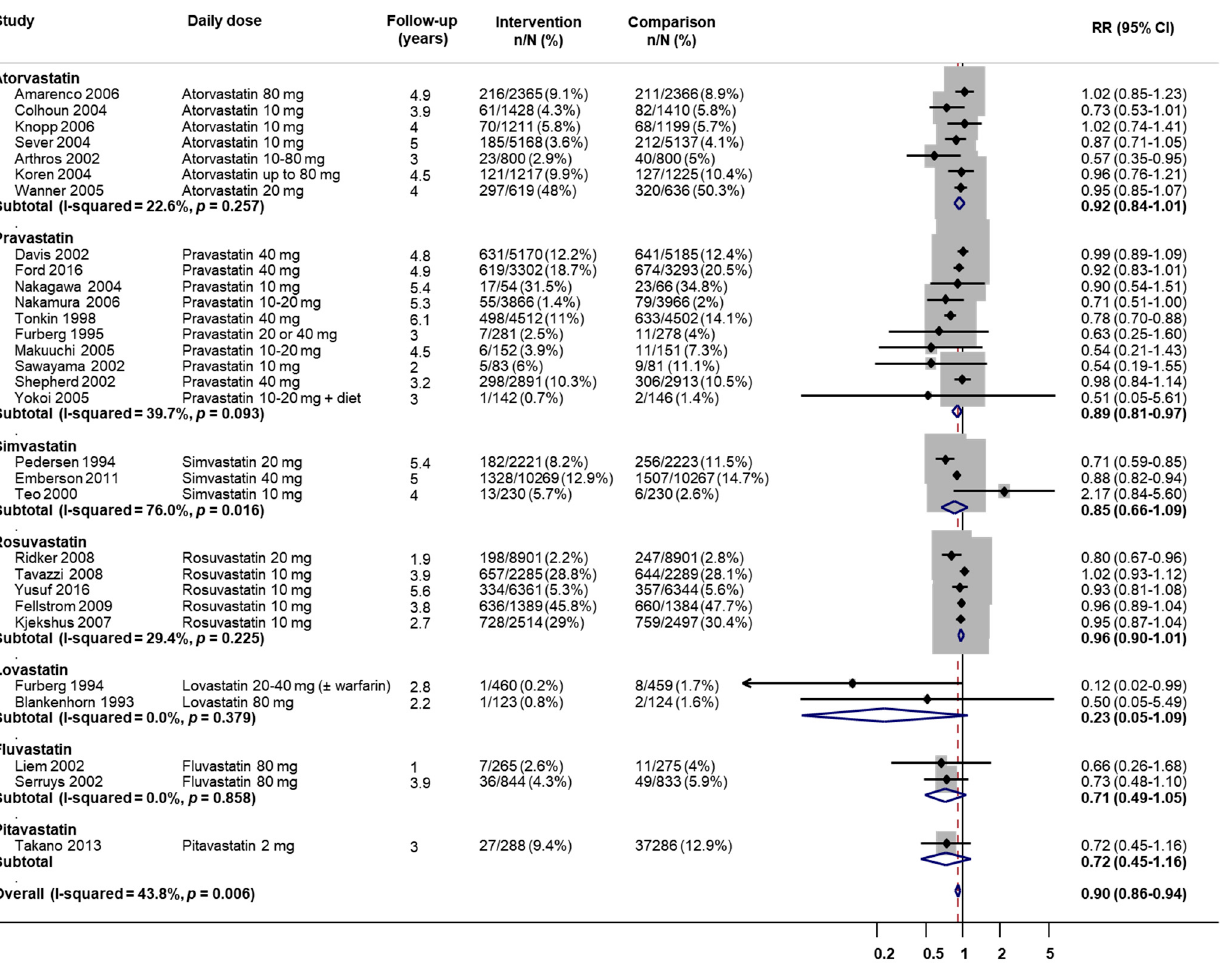
Figure A2. Subgroup meta-analysis for the effect of different statins on all-cause mortality. Full black quadrilateral represents the point estimate of individual studies and blank with quadrilateral represents pooled estimates. RR, relative risk; CI, confidence interval. Bold font indicates statistical significance.